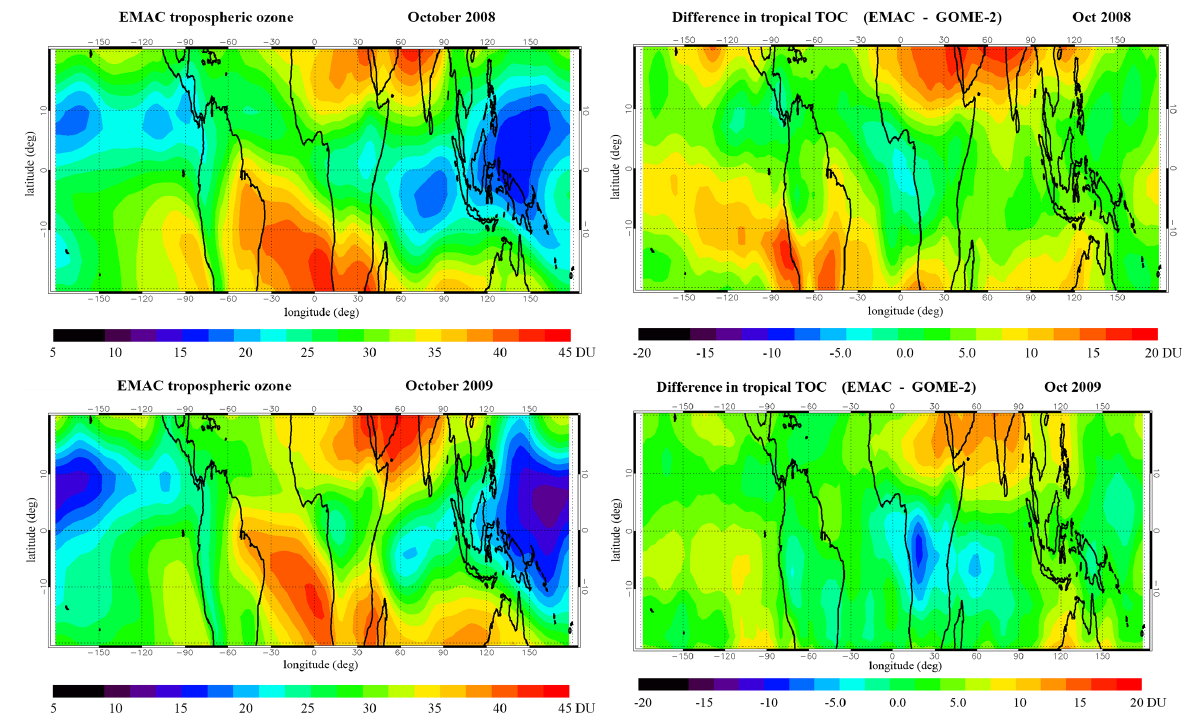
Figure 8. Tropospheric ozone columns calculated with the EMAC model (left) and the difference in the tropospheric ozone columns from EMAC and GOME-2 (right). The maps are for October 2008 (top) and 2009